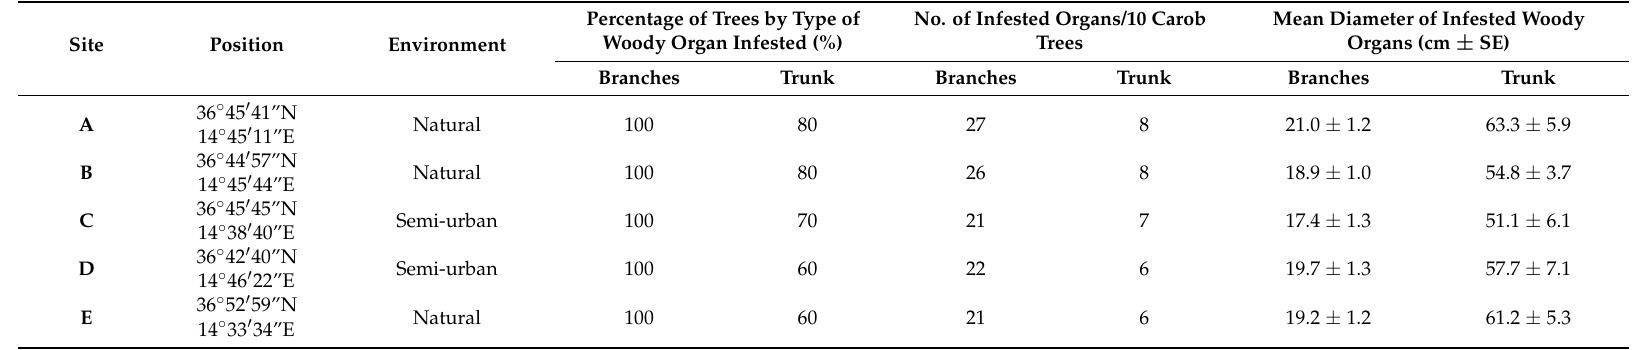
Table 1. Level of infestation and mean diameter of different Carob tree organs infested by Xylosandrus compactus in five sites in Sicily (Italy) in 2017 (A and B) and 2018 (C, D, and E).